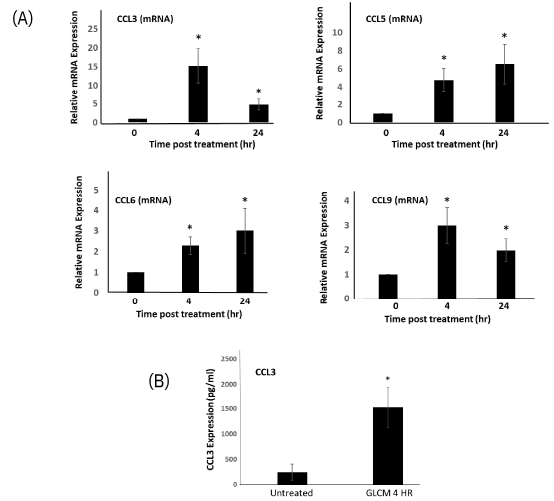
Figure 3. Glioma conditioned media stimulates expression of CCR1 ligands in microglia. ( A ) quantitative PCR was performed on RNA extracted from MG cells treated with GL261 conditioned media for 4- and 24-h using primers specific for CCL3, CCL5, CCL6 and CCL9. * p value < 0.05. ( B ) Secretion of CCL3 was evaluated using ELISA on MG cell supernatants treated with GL261 conditioned media for 4 h, p value < 0.05. Data are mean − /+ SEM (n =